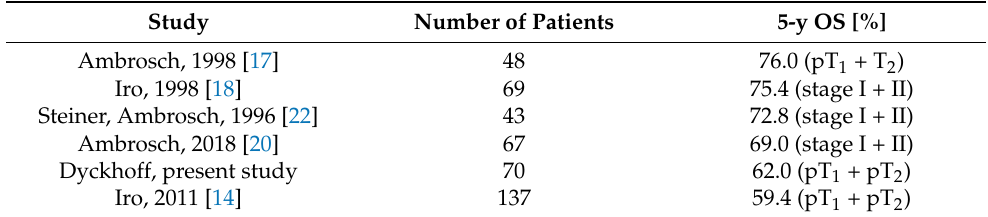
Table 7. 5-year OS of early-stage supraglottic cancer patients after TLM in different